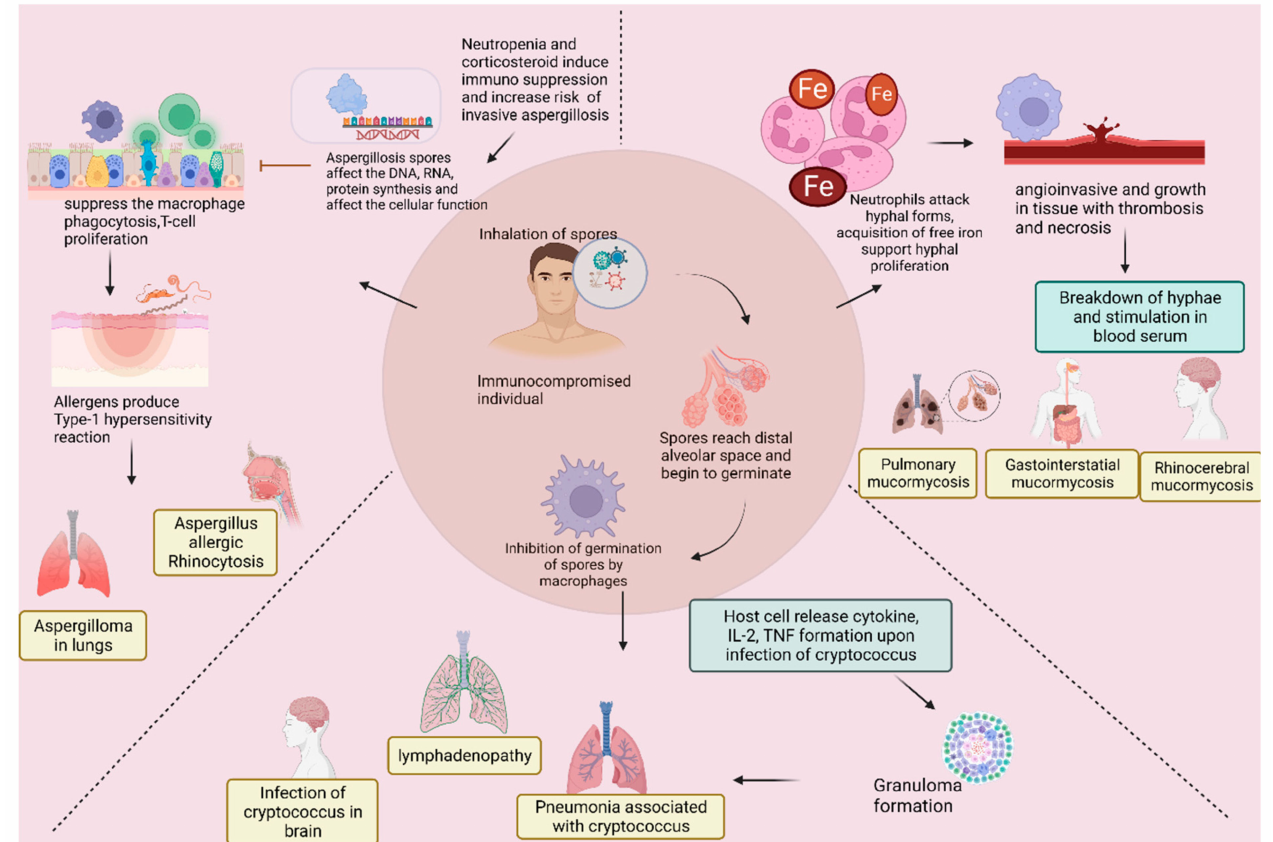
Figure 1. Mechanism of the pathogenesis of invasive aspergillosis, mucormycosis, and cryptococcus fungal infections and their complications (Created using